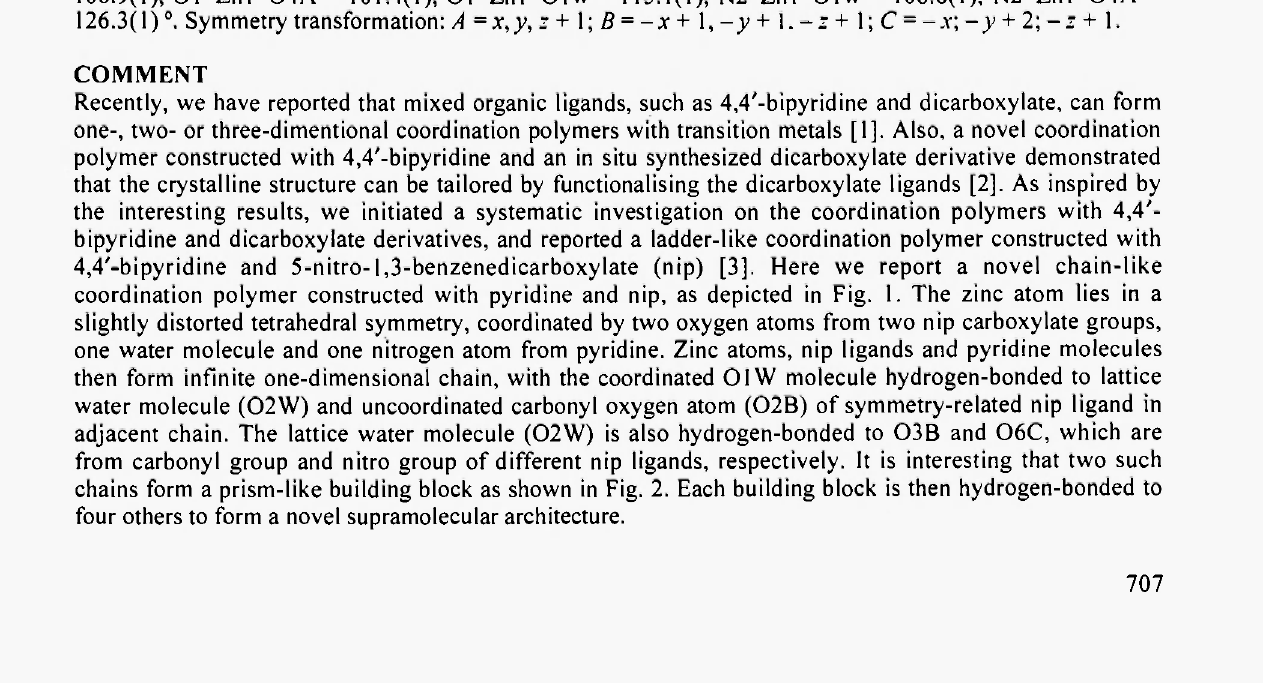
Figure 1. ORTEP plot of the title complex at the 35% probability level. Selected bond distances and angles: Znl-Ol = 1.977(2), Znl-04A = 1.973(2), Znl-Olw = 1.971(2), Znl-N2 = 2.014(2) 0 1 W - 0 2W = 2.616(3), 0 1 W - 0 2B = 2.692(3), 0 2 W - 0 3B = 2.708(3), 0 2 W - 0 6C = 2.851(4) Ä; 01-Znl-N2 = 106.9(1), 0 1 - Z n l - 0 4A = 101.4(1), Ol-Znl-Olw = 115.1(1), N2-Znl-01w = 106.8(1), N2-Znl-04A = 126.3(1) Symmetry transformation: A =